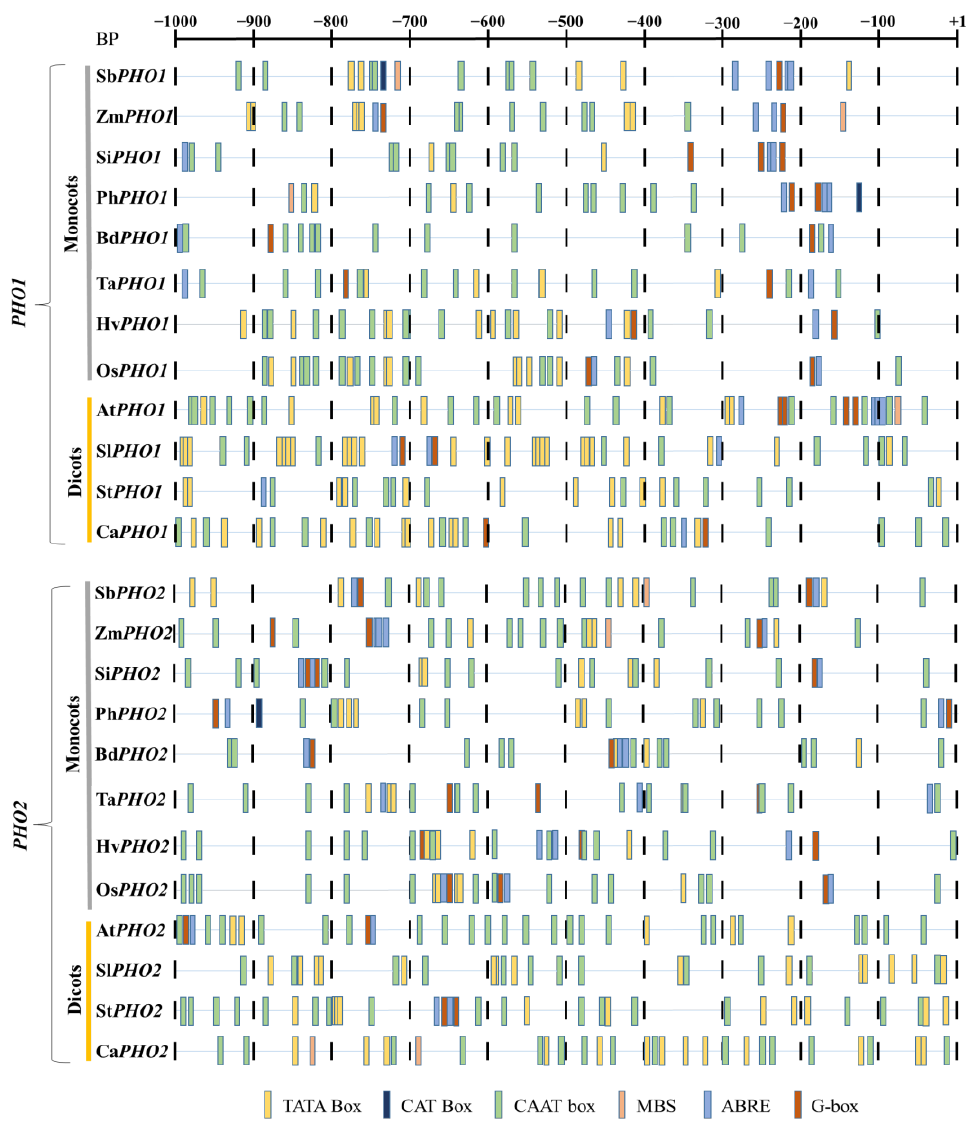
Figure 3. Representative figure showing regulatory elements identified in the 1 kb upstream region of PHO1 and PHO2 . Different color bars represent the major regulatory elements. Symbols